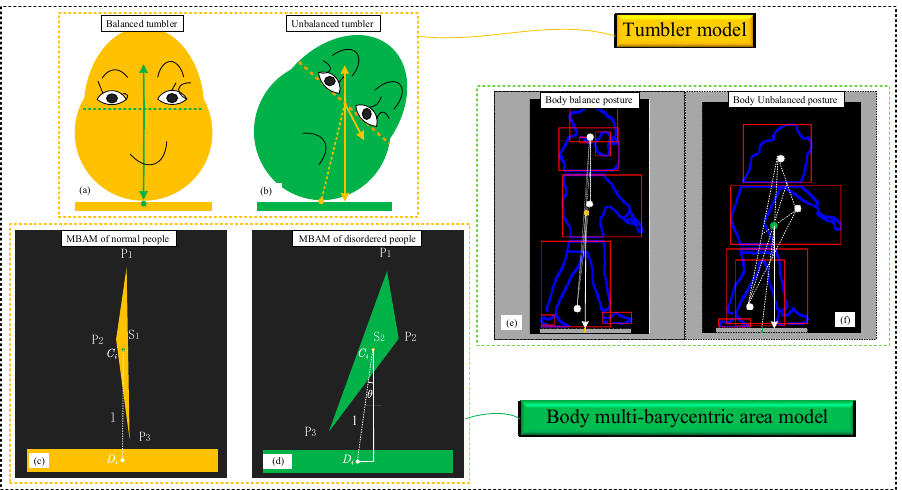
Figure 1. figure of multi-barycentric area model (MBAM). ( a ) Balanced tumbler. ( b ) Unbalanced Tumbler. ( c ) MBAM of normal people. ( d ) MBAM of disordered people. ( e ) Balanced human body posture. ( f ) Unbalanced human body posture.